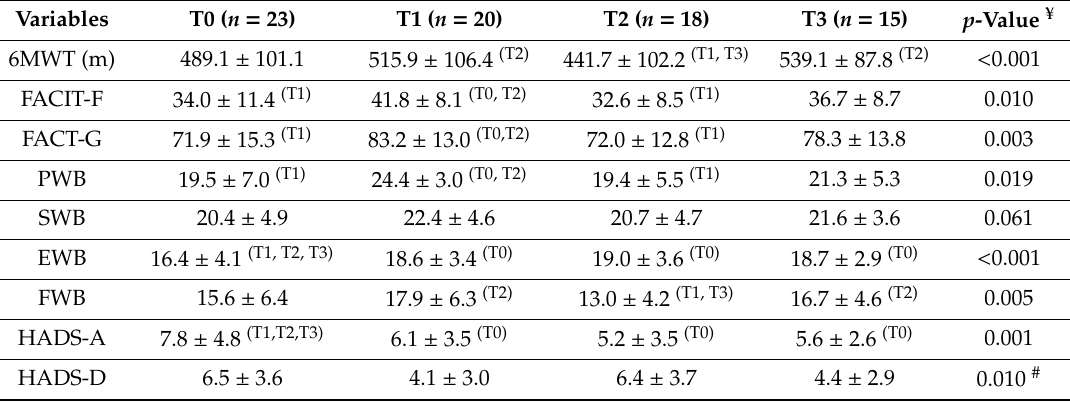
Table 3. Evolution after tele-prehabilitation on functional exercise capacity, cancer-related fatigue, quality of life, anxiety and depression in esophagogastric cancer